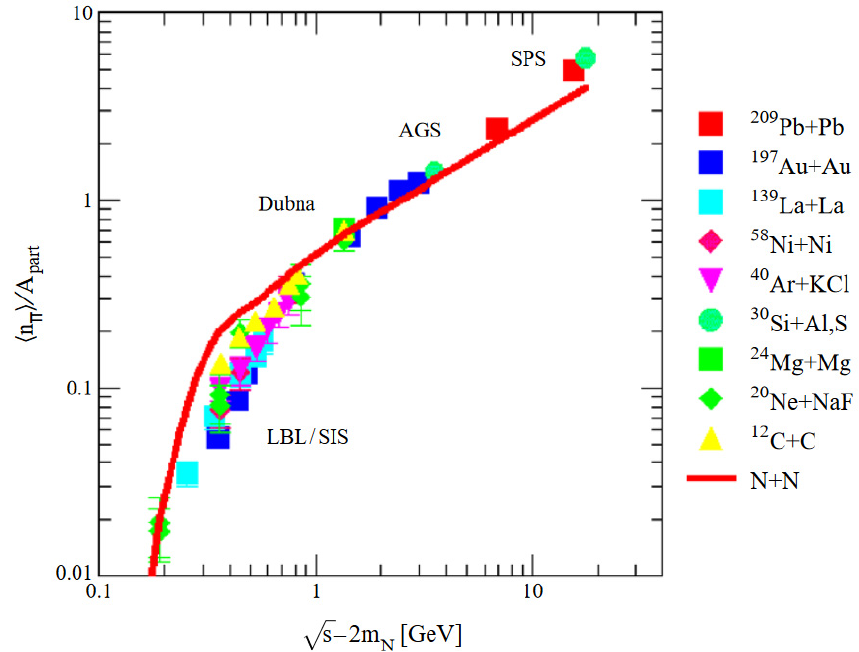
Figure 3. Pion multiplicity per participating nucleon measured in nucleus–nucleus collisions (sym- bols) and in nucleon–nucleon collisions as a function of available energy in the NN system (taken from [33]).